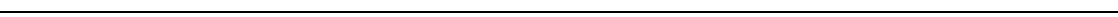
Fig. 5 The YAP1 inhibitor Vertepor fi n (VP) impacts cell survival, proliferation, and tumor growth. a Dose-response experiment for cell viability